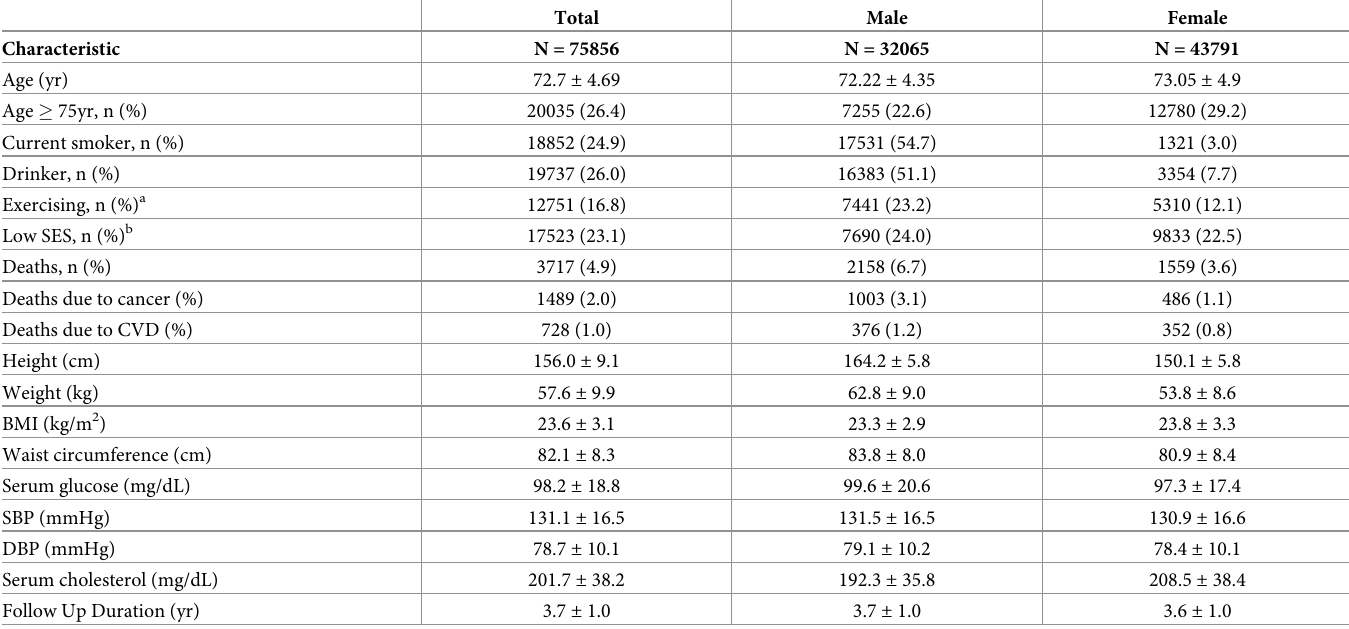
Table 1. Participants